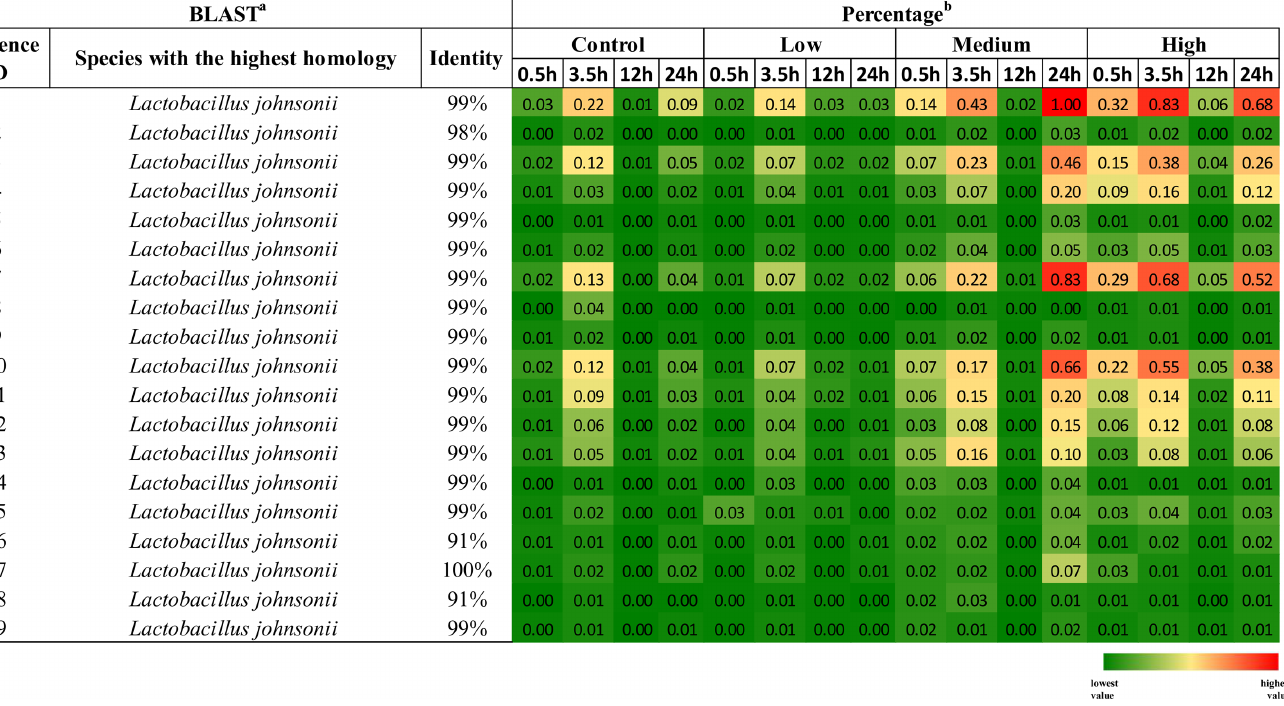
Fig 3. The species of Lactobacillus detected in the cecums of L . casei fed mice. The species of Lactobacillus with the highest 16S rRNA sequence identity to those present in the cecums of L . casei fed mice Lactobacillus sequences detected were blasted against NCBI database to identify the species with the highest identity (a). The heat map depicts the relative abundance of Lactobacillus sequences detected in the cecums of L . casei fed mice. The percentage was calculated from the average values for each sample (n:6/time point) and a graded color scale is utilized to visualize the relative abundance